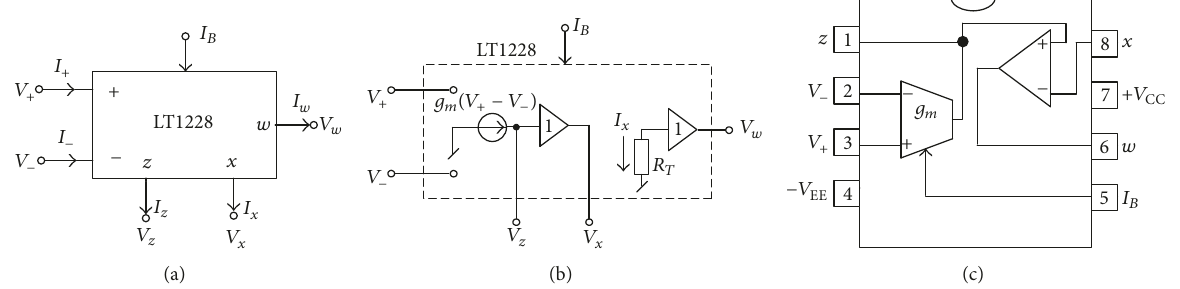
Figure 1: LT1228. (a) Electrical symbol of LT1228. (b) Equivalent circuit. (c) Pin configuration.